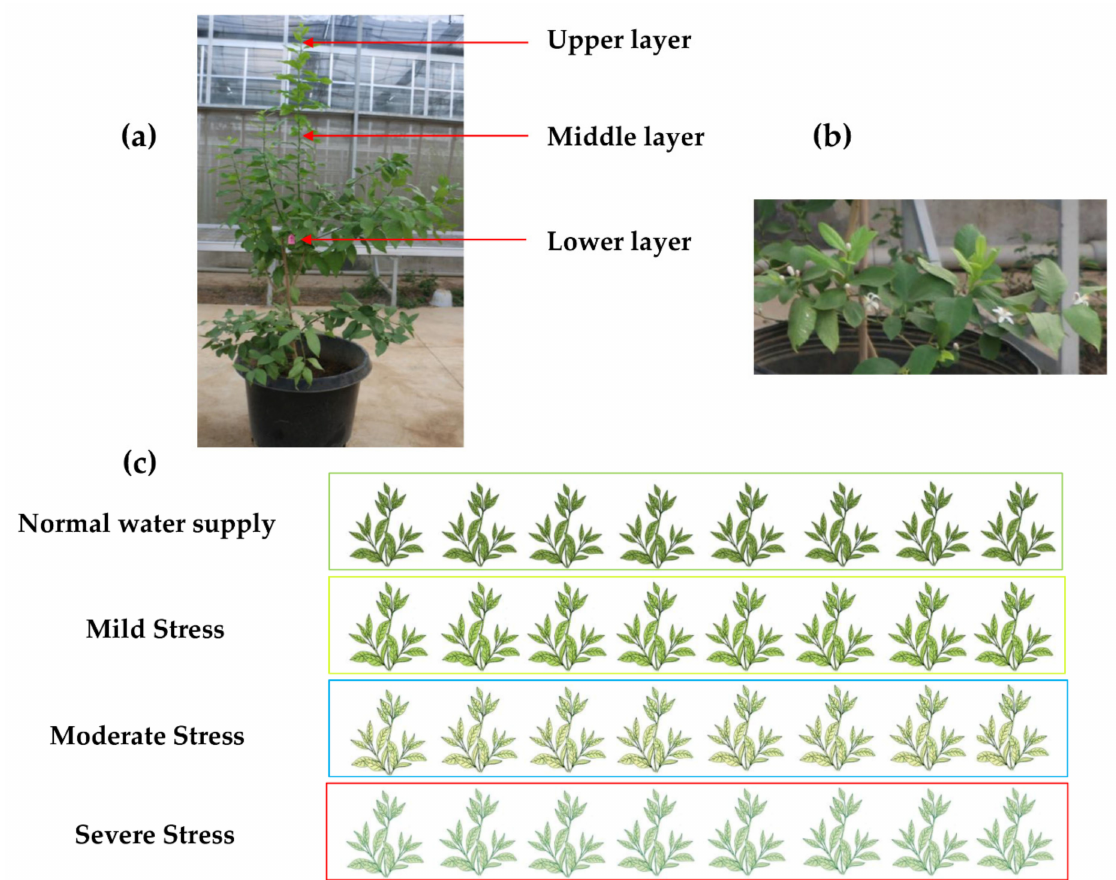
Figure 1. ( a ) the position of upper layer, middle layer and lower layer; ( b ) in the process of drought treatment, citrus trees of severe stress had obvious physiological changes and even bloomed early; and ( c ) experimental